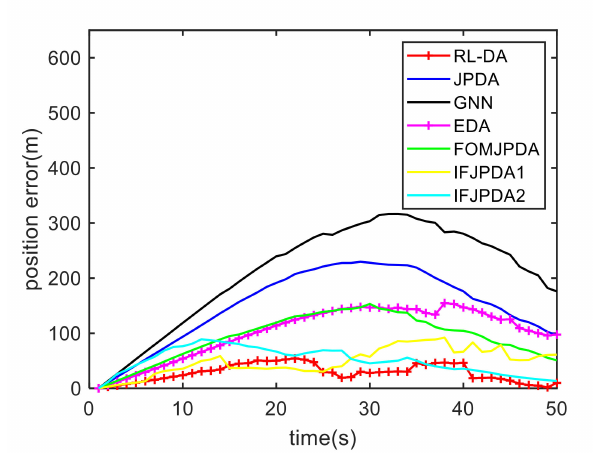
Figure 23. Comparison of the position errors for Target 3 in Case 1.